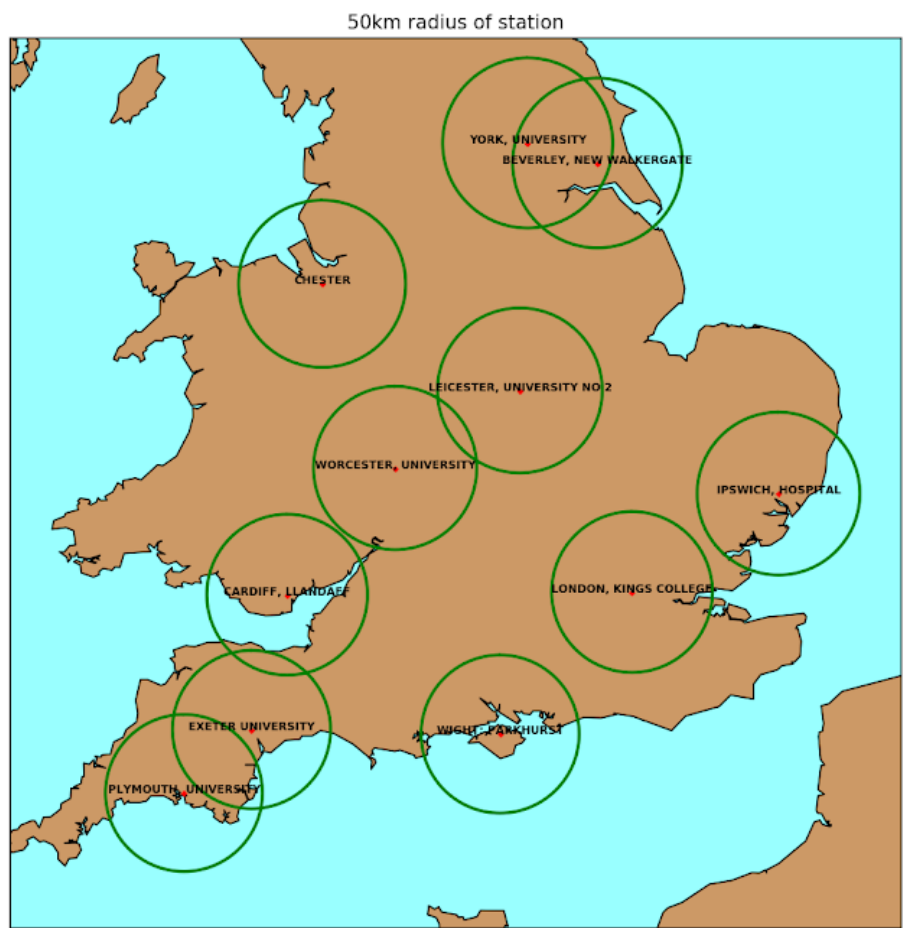
Figure 3. Pollen monitoring station locations (red dots), with green circles indicating the 50 km radius around each station. Table 1. Pearson’s r , for the relationship between number of tweets within a 50 km radius of each pollen observation station and the pollen counts observed at each station, for all pollen types and grass pollen only. Text colour indicates p -value (Red: p ≥ 0.05, Blue: 0.01 ≤ p < 0.05, Black: p < 0.01). Correlation Between Correlation Between ALL No. of Tweets in 50 km GRASS Pollen Counts Pollen Counts and Tweets Radius of Station and Tweets 0.9